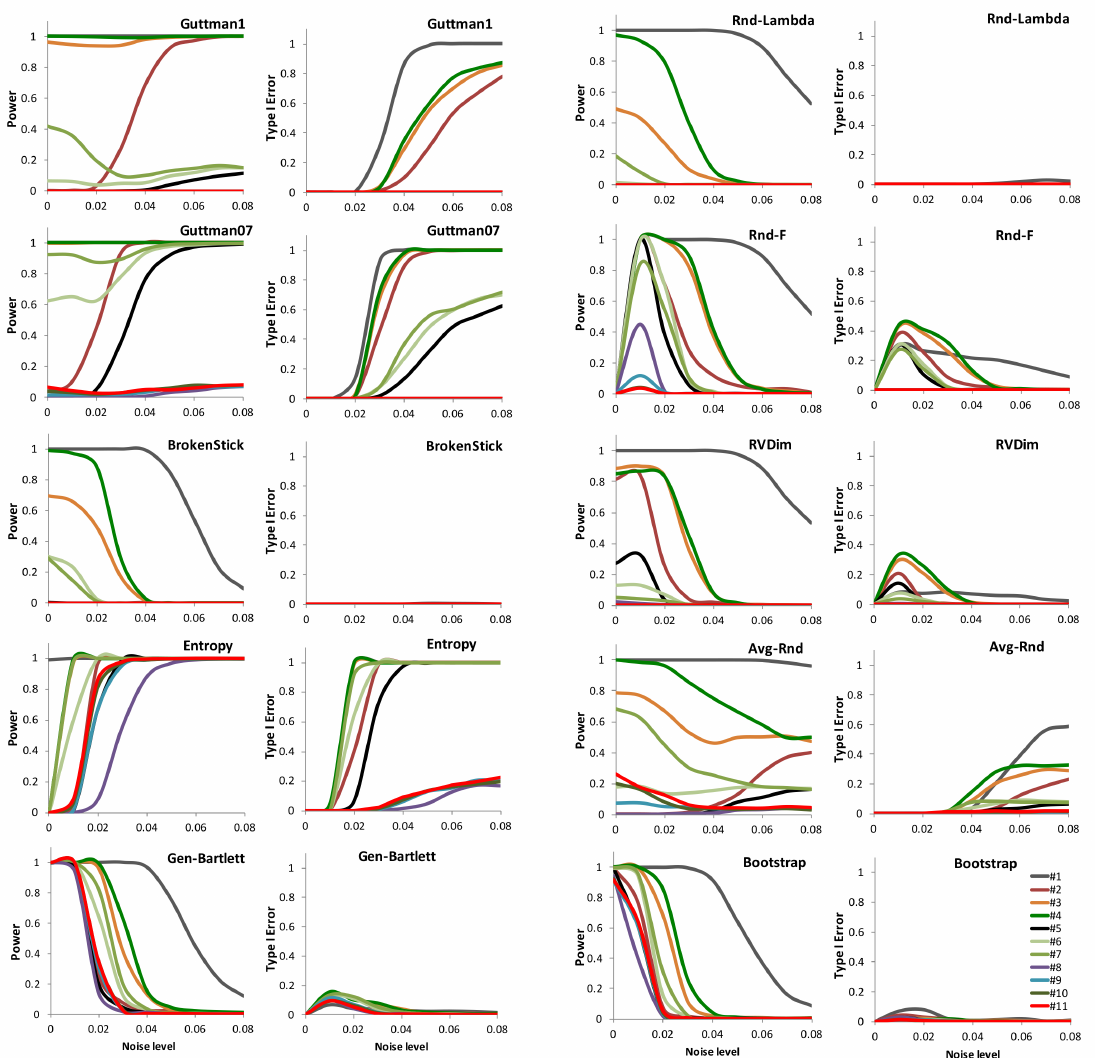
Figure 1. Experiment results. The graphics represent the power and type-I error of the ten stopping rules for PCA in defining both signal and noise dimensions under increasing levels of added noise (horizontal axis), considering nine variables with normal distribution and sample size of 30 units. The coloured lines correspond to the eigenstructures of the simulated datasets defined in Table 1. Columns 1 and 3: Graphs for power, referring to the last signal dimension. Columns 2 and 4: Graphs for type-I error, referring to the first noise